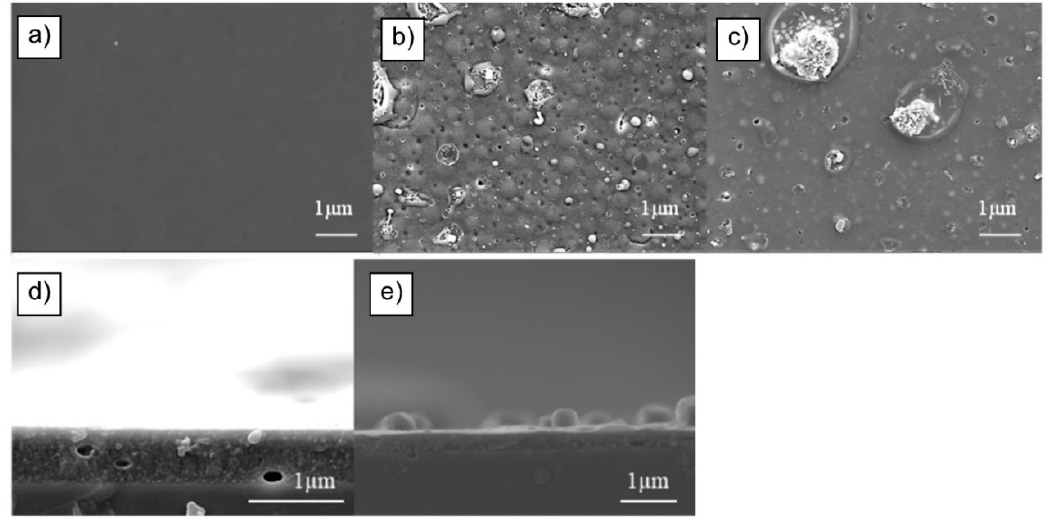
Figure 7. Planar and cross-sectional SEM images of a hydrophobic coating C deposited by dip-coating—( a , d ) as-deposited; ( b , e ) after 500 h; and ( c ) after 1000 h of DH showing blister formation.